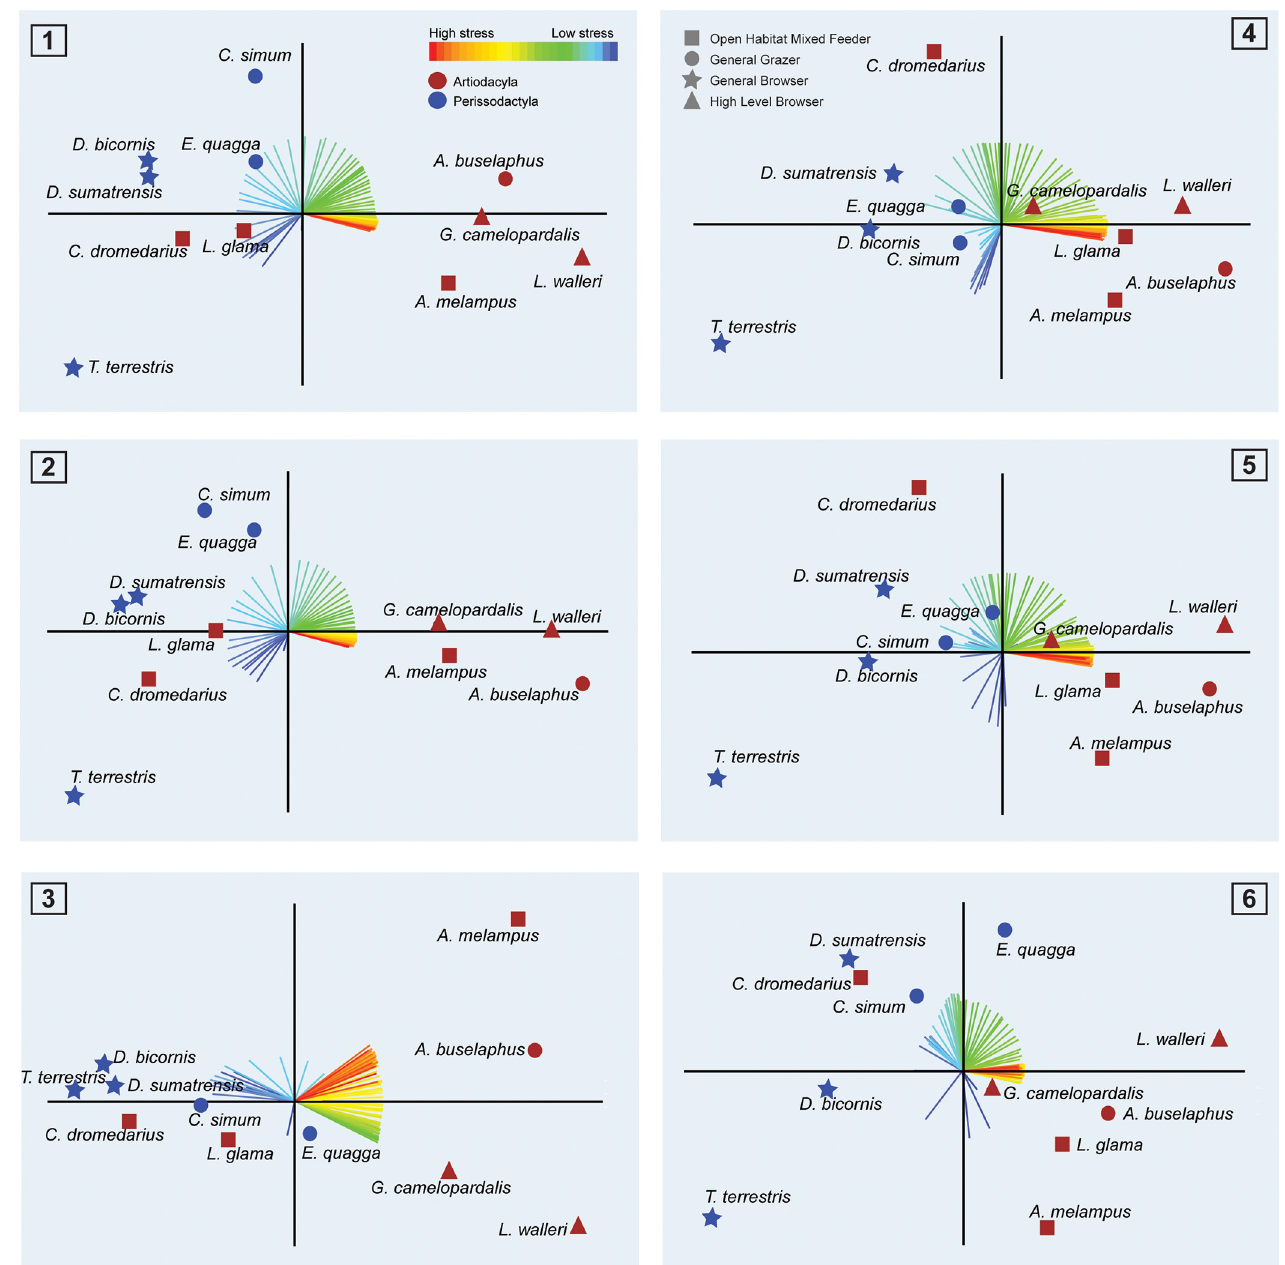
Fig 8. Biplot of PCAs based on the correlation matrix for the six biting cases: Lateral cases 1) in M1 2) in M2 and 3) in M3. Orthal cases 4) in M1 5) in M2 and 6) in M3. The loadings for each variable are coloured according stress intensity. Red colours indicate high stress, blue indicate low stress. X-axis: PC1. Y- axis: